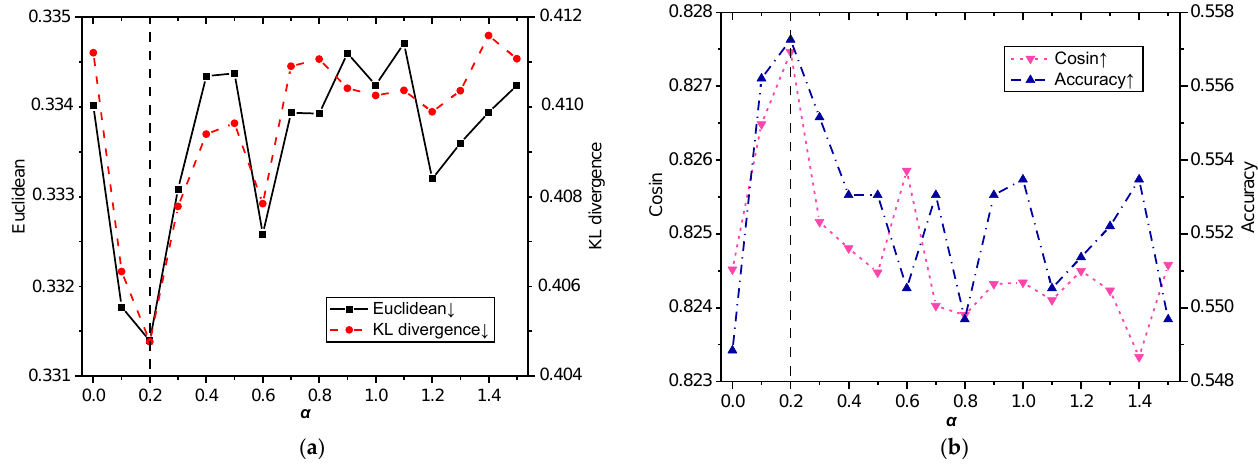
Figure 3. The influence of the weight coefficient 𝛼 on the performances of the LMT-CNN model on the Semeval dataset ( ↑ means that the larger the indicator is, the better, and ↓ means that the smaller the indicator is, the better). ( a ) Euclidean and KL Divergence ; ( b ) Cosine and Accuracy .